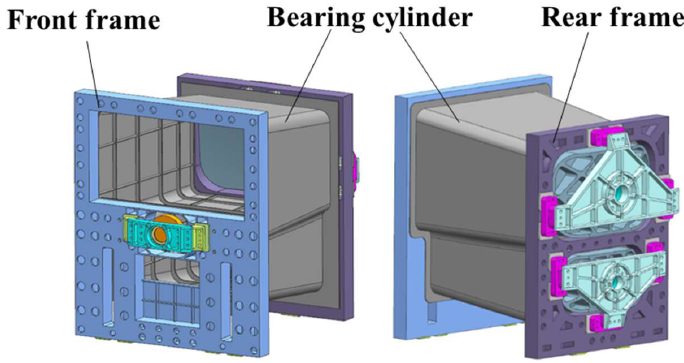
Figure 2. Support structure for the off-axis TMA camera.